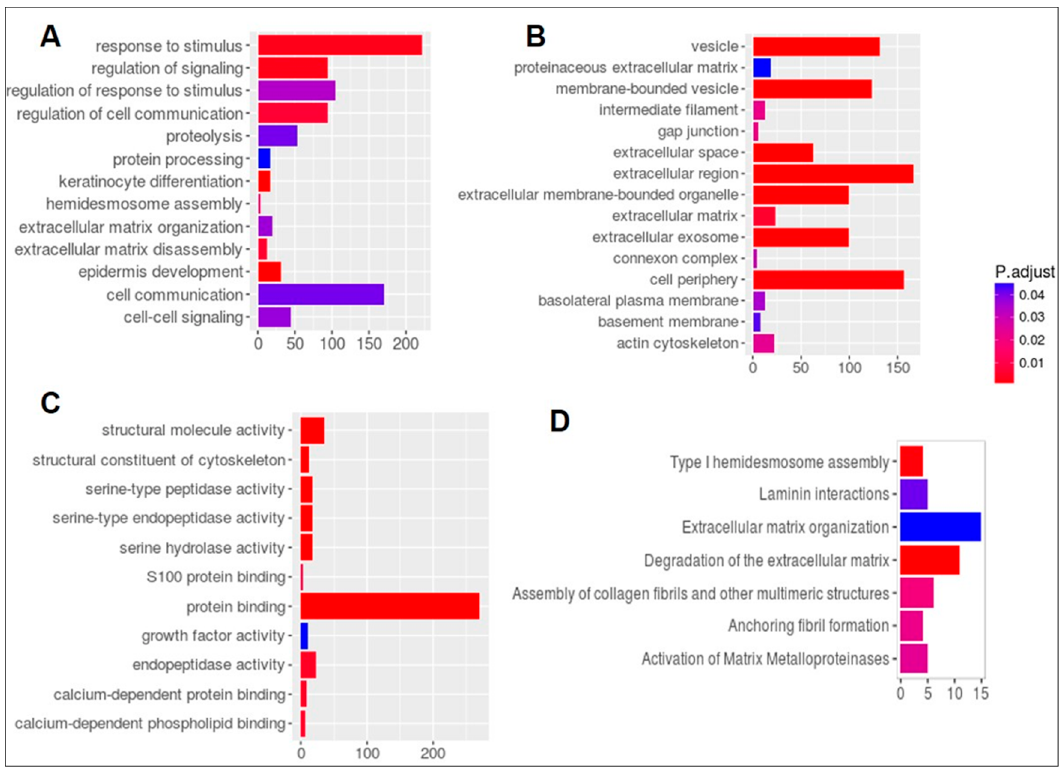
Figure 4. Analysis of Gene Ontology (GO) and signaling pathways associated with KLK6 overexpression in TCGA colon adenocarcinoma samples. Analysis of DEGs for GO shows ( A ) Biological processes. ( B ) Cellular Components and ( C ) Molecular Functional gene sets that are significantly enriched in high expressing KLK6 group. ( D ) Reactome pathways that are enriched in DEGs.